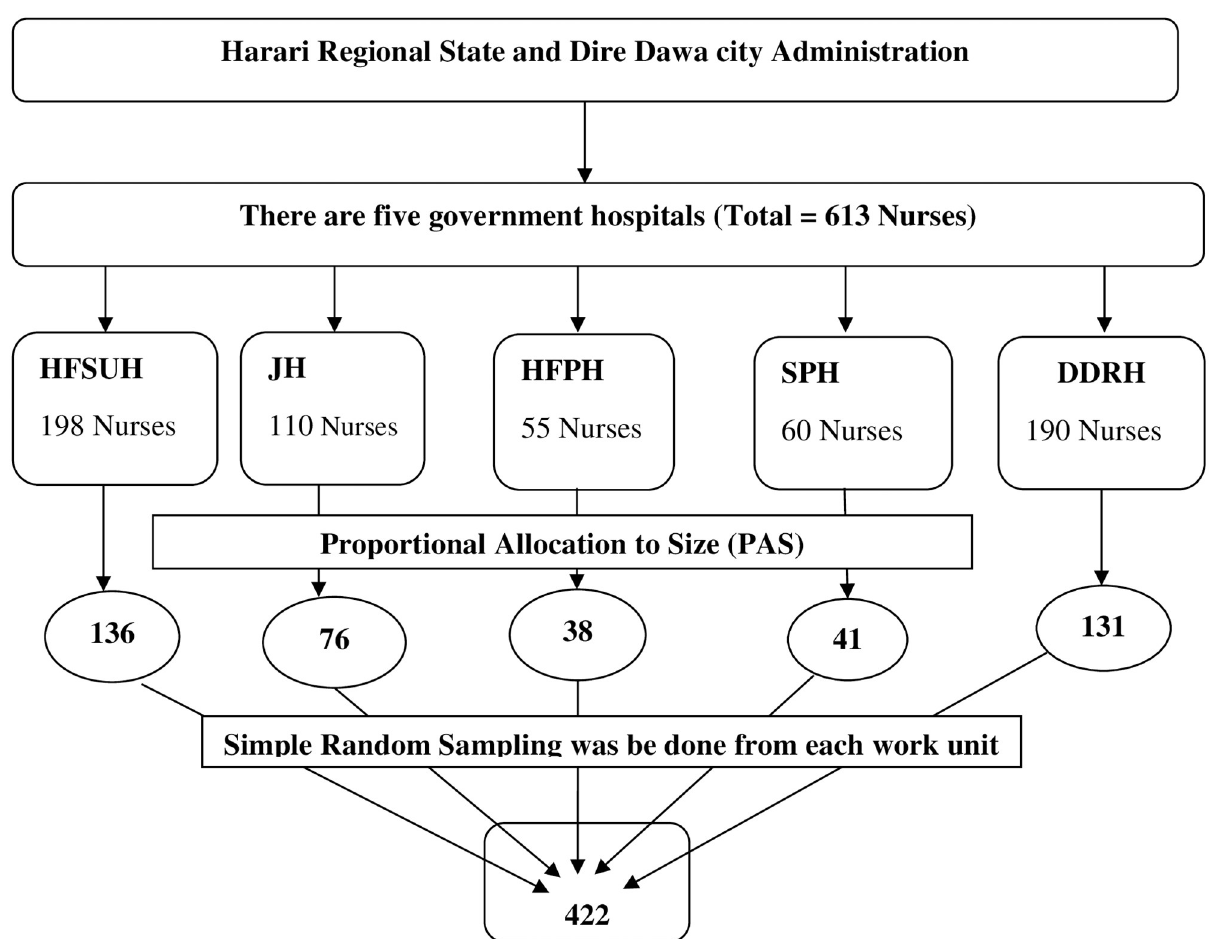
Fig 1. Schematic diagram of the sampling procedure for the study to assess pressure ulcer prevention practice and associated factors among nurses working in public hospitals of Eastern Ethiopia, 2018.